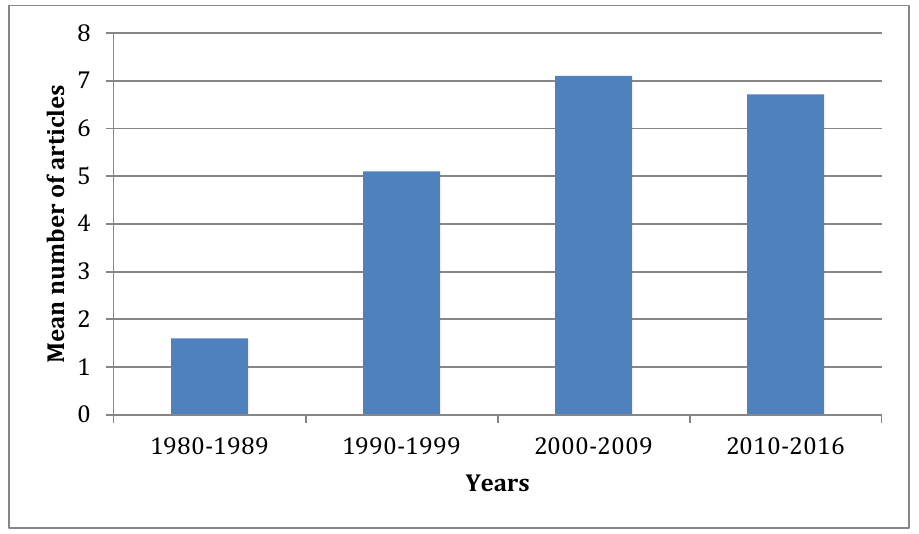
Figure 1. Mean number of articles on teacher and collegiality and professionalism in this paper’s selected journals